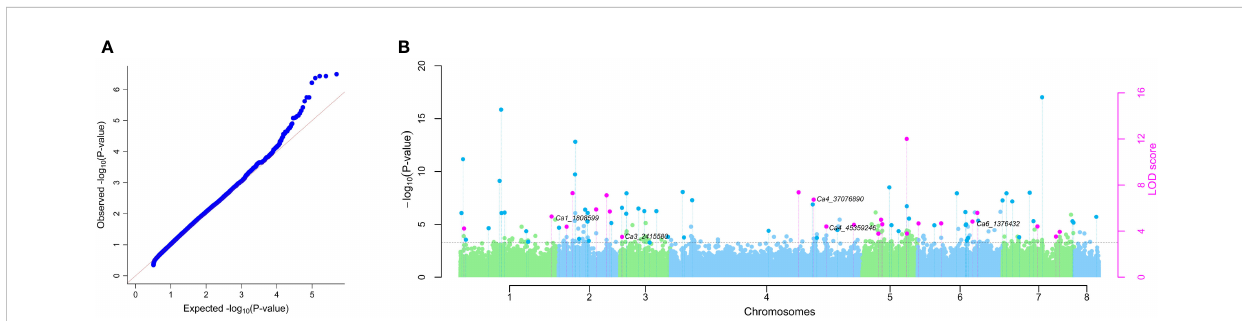
FIGURE 3 Multi-locus GWAS. (A) Quantile-quantile plot for comparison between expected and observed – log10 (P-values). (B) Manhattan plot for signi fi cant QTNs associated with P. thornei resistance in chickpea using mrMLM, FASTmrMLM, FASTmrEMMA, pKWmEB, pLARmEB and ISIS EM-BLASSO models. The -log10 (P-value) and the LOD score of SNP across the genome (y-axes) were plotted against their respective position on each chromosome (x-axis). The pink dots above dotted vertical lines represent all the QTNs commonly identi fi ed by multiple approaches and the dark blue dots above dotted vertical lines indicate QTNs identi fi ed by a single GWAS model. Candidate gene analysis revealed QTNs Ca1_1808599, Ca4_37076890 and Ca6_1376432 were fl anked by Receptor-linked kinases (RLKs). QTN Ca3_2415580 was fl anked by GDSL-like Lipase/ Acylhydrolase. QTN Ca4_45359246 was fl anked by Aspartic proteinase like and Thaumatin-like protein and QTN Ca6_1376432 was fl anked by AT- hook DNA-binding and